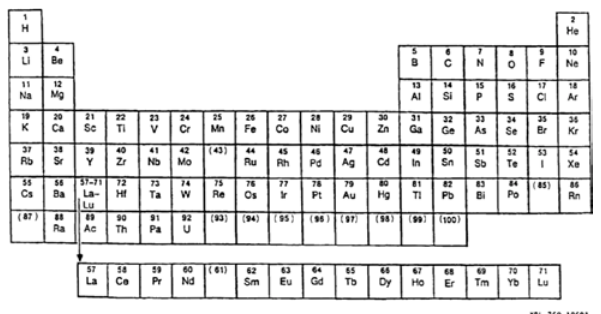
Figure 10. The Lawrence Berkeley periodic table of the 1930s.